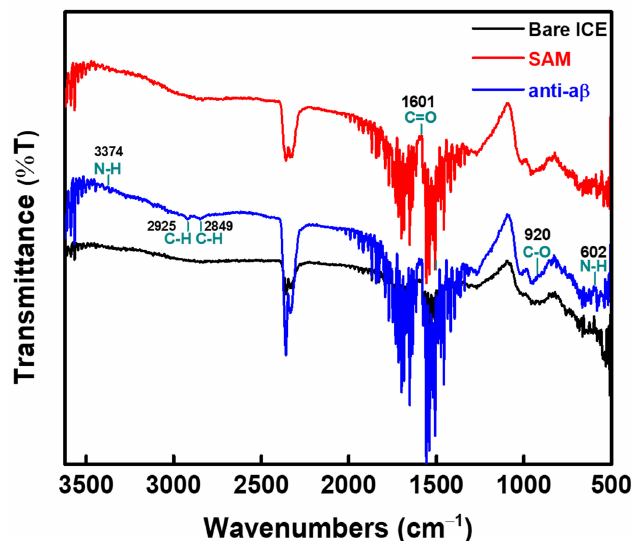
Figure 4. FT-IR results for the fabrication of the anti-a β /SAM/ICE